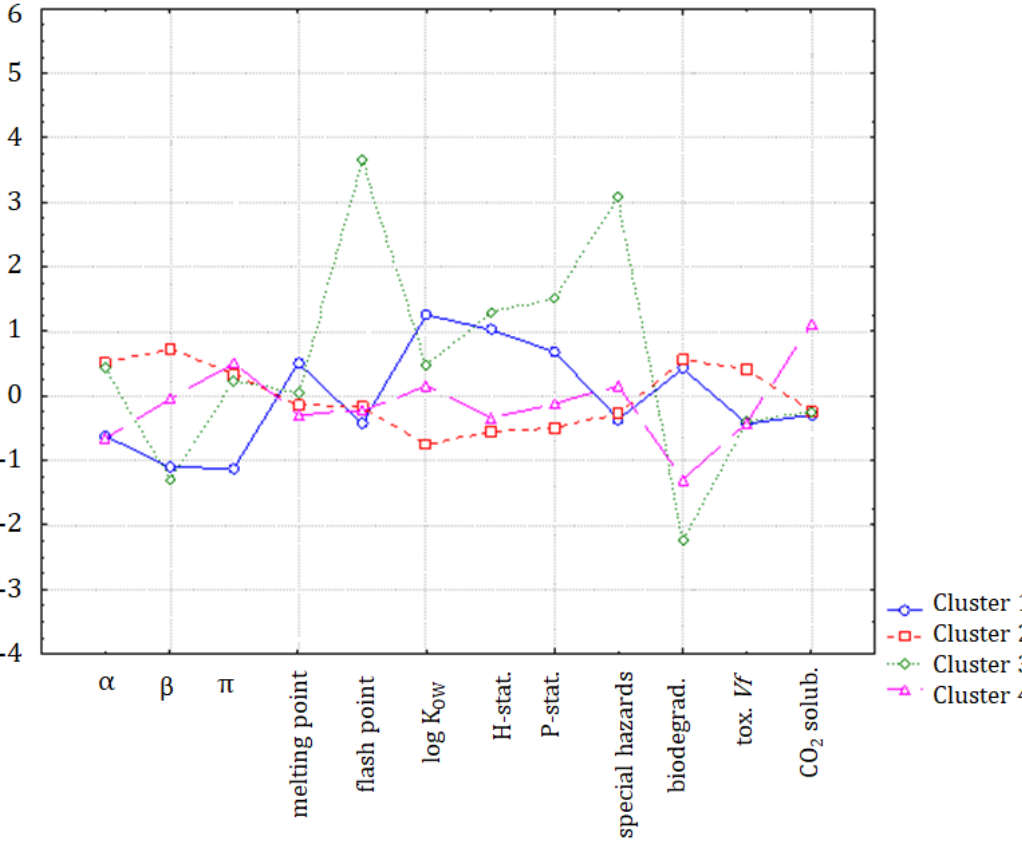
Figure 10. The average values (standardized) for each variable, and for each identified cluster.